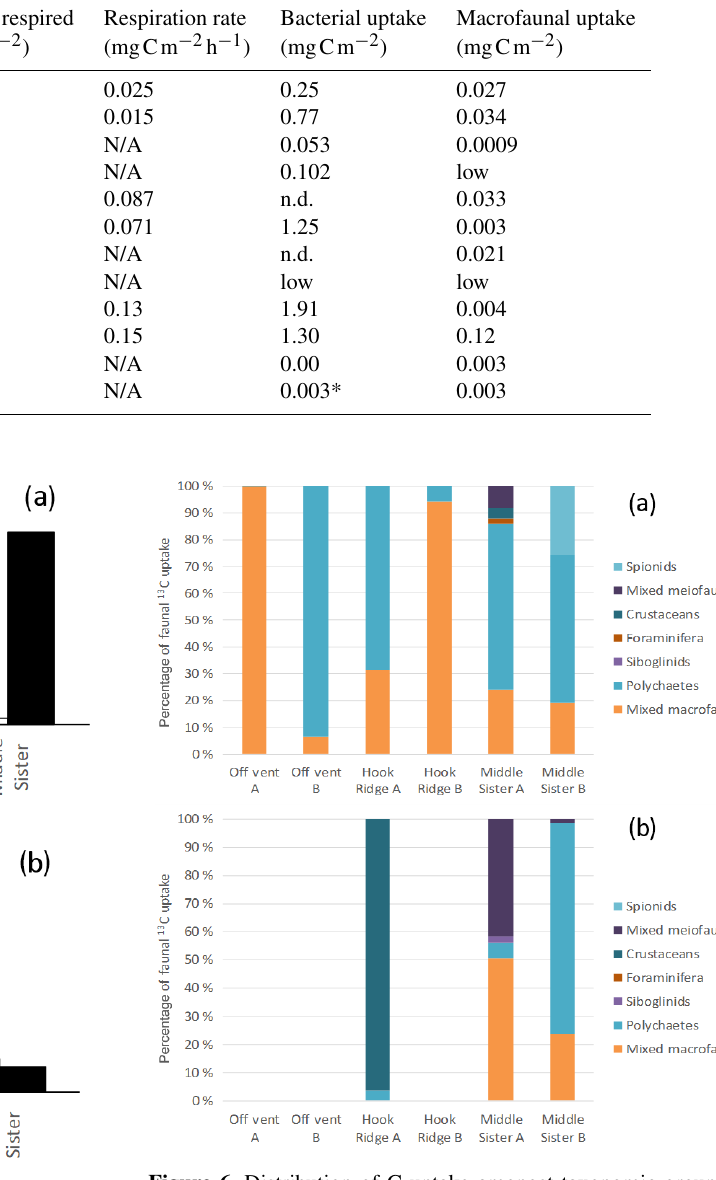
Figure 5. Faunal uptake in (a) algae addition experiments and (b) bicarbonate addition experiments. A and B refer to the two repli- cate cores in each experiment.